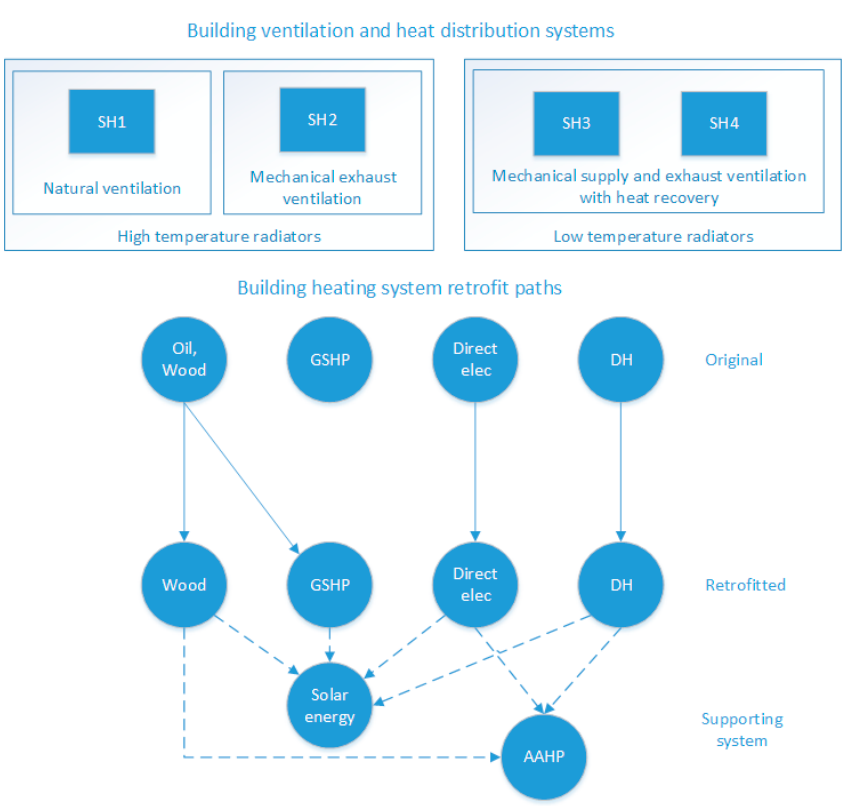
Figure 4. Retrofit paths for buildings with different heating systems.